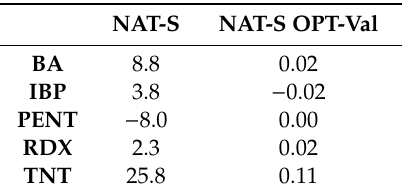
Table 4. Prediction of %DNT from the NAT-S models.